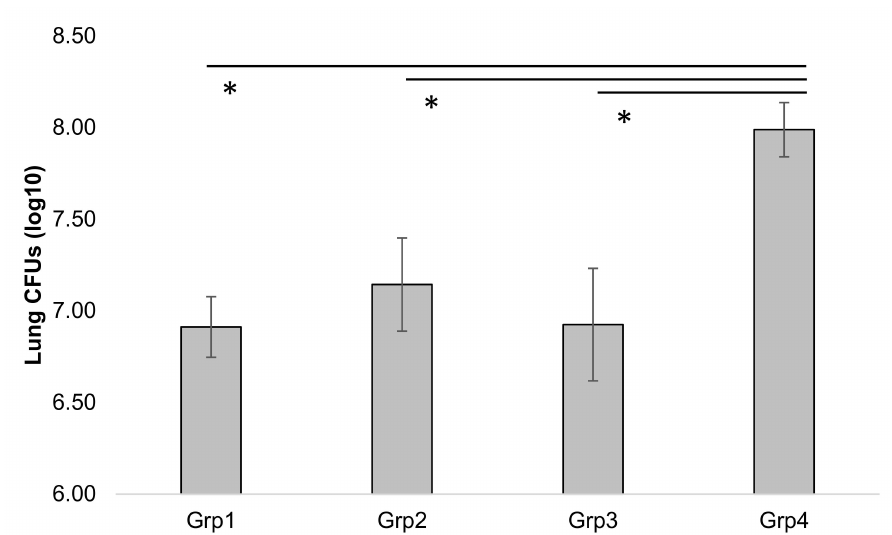
Figure 6. Lung CFUs in mice 14 days post-challenge, with standard error. Statistically significantly lower levels of colonies were observed in all Ag2 treatment groups (Grp 1 to 3) compared to the control group (Grp4; p < 0.05), as represented by asterisks (*). Each group received two doses (days 0 and 14) of injected Ag2b (Grp1), injected Ag2m (Grp2), co-administered injection with orally fed Ag2m wafers (Grp3), or control injection with control Ag2m wafers (Grp4).